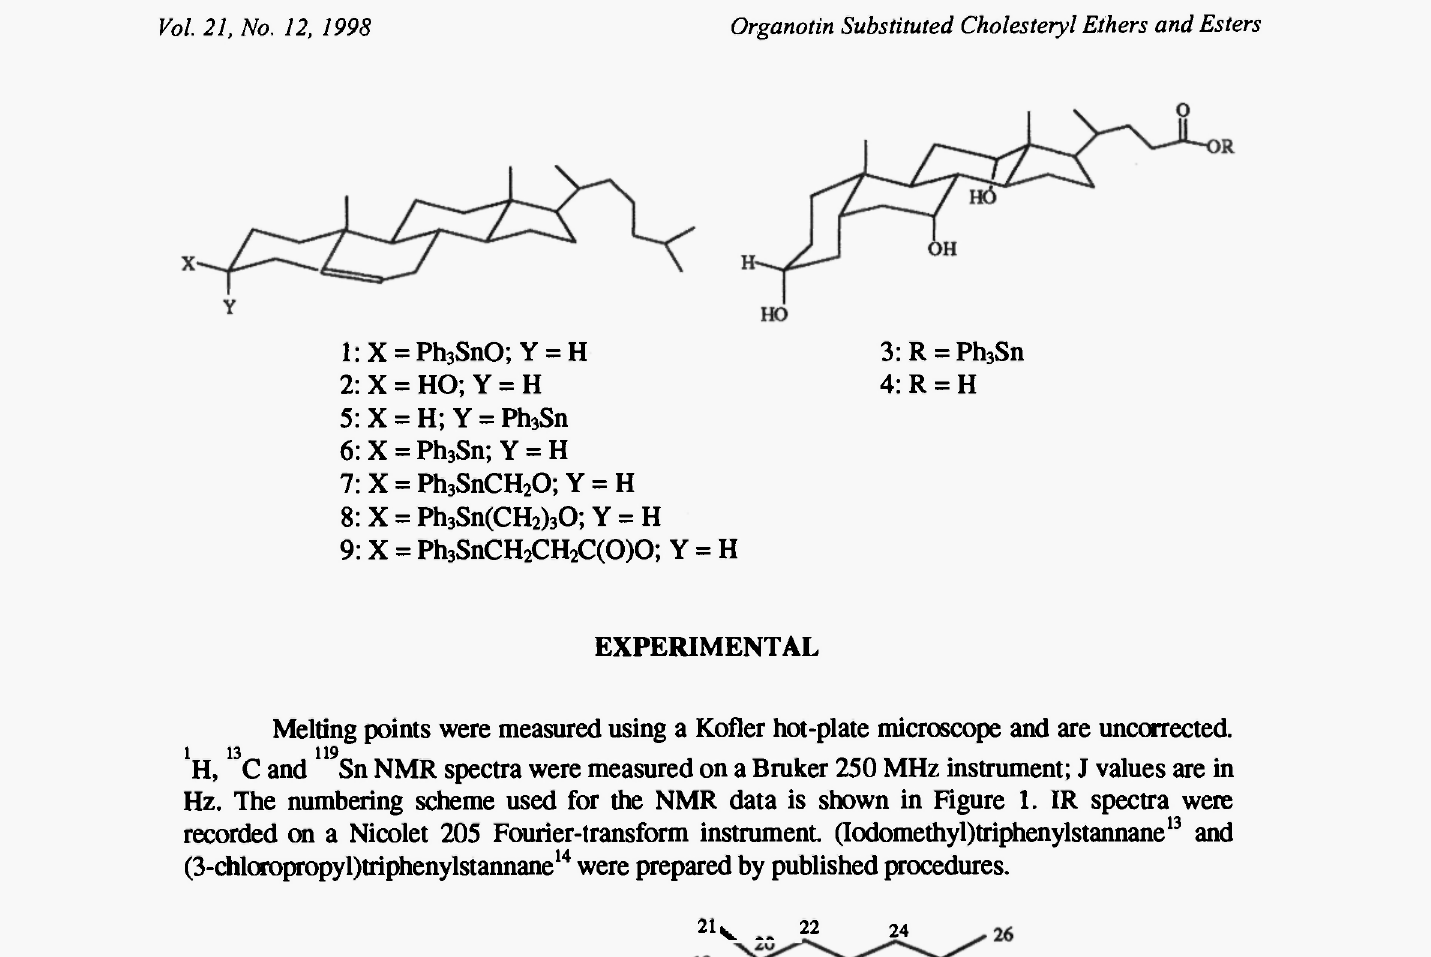
Figure 1. Numbering scheme for cholesteryl